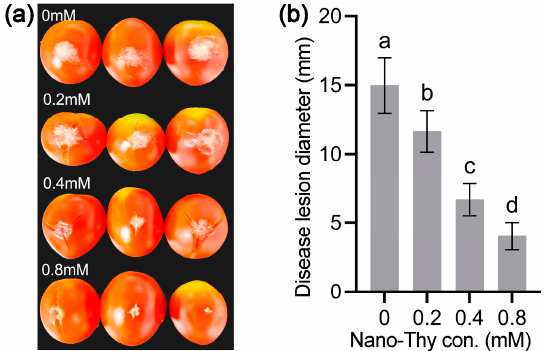
Figure 10. The effect of Nano-Thy on the infection of B. cinerea in tomato fruit. ( a ) Phenotype of tomatoes; ( b ) measurement of disease lesion diameter on tomatoes. Lowercase letters in ( b ) indicated significant difference among treatments (ANOVA, n = 3, p < 0.05).